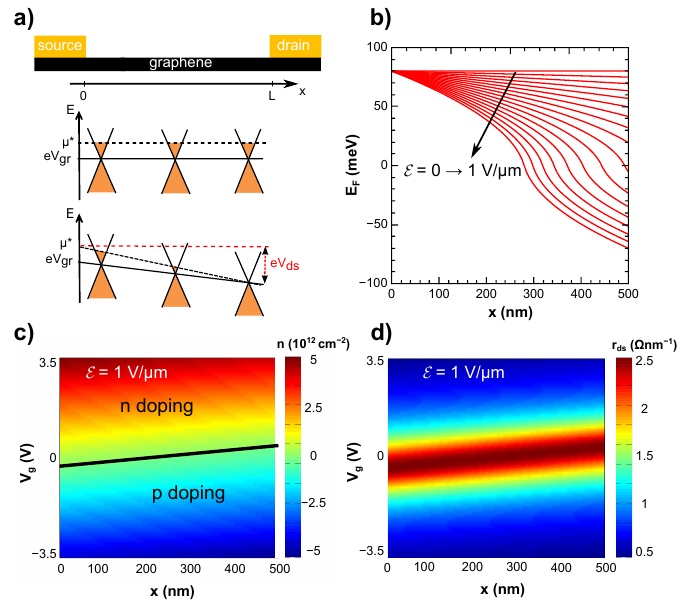
Figure 4. ( a ) Sketch of the doping profile across the graphene channel when V ds is increased. Starting from n-doping, ∆ E F ( x ) can be decreased down to neutrality at the drain side. This is the Dirac pinch-off. ( b ) Simulated E F ( x ) along the channel for increasing in-plane electric field. ( c ) Color plot of the local carrier density in the channel as a function of the x-position along the channel and the gate voltage V g = 0.5 V. The total resistance of the device is the ( d ) Color plot of the local resistivity r ds ( V g , x ) at V 0 ds integration over x of this